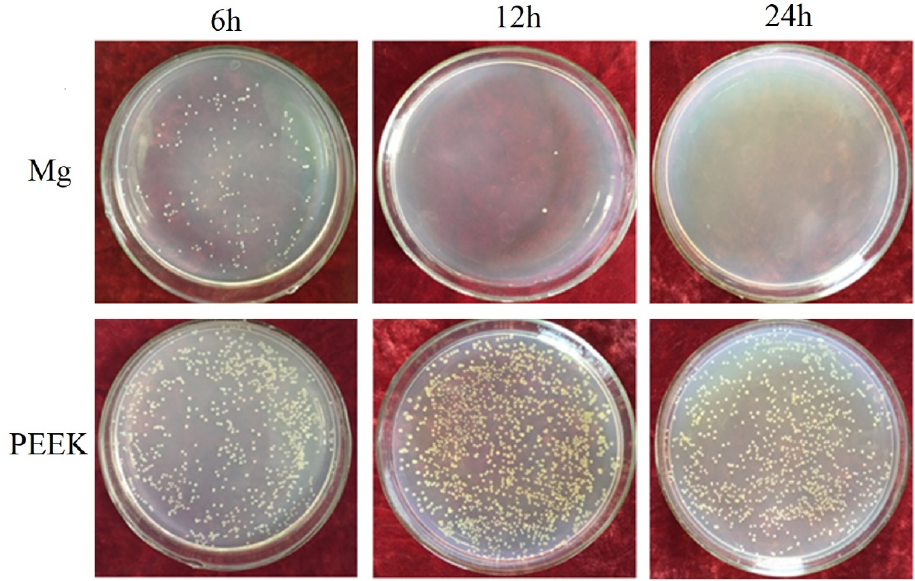
Figure 7. Antibacterial effects of PEEK with and without Mg coating co-cultured with S. aureus at 37 °C for 6, 12, and 24 h.